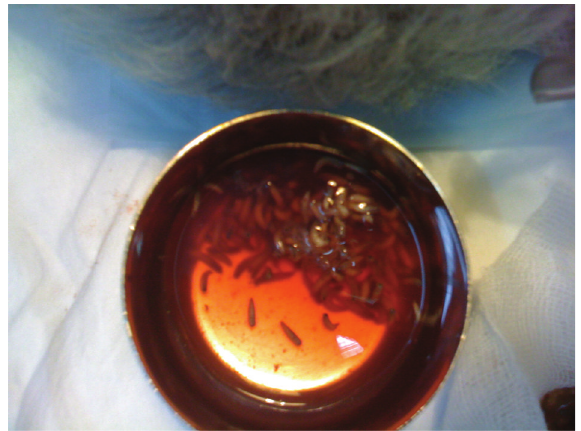
Figure 4: Maggots removed on day